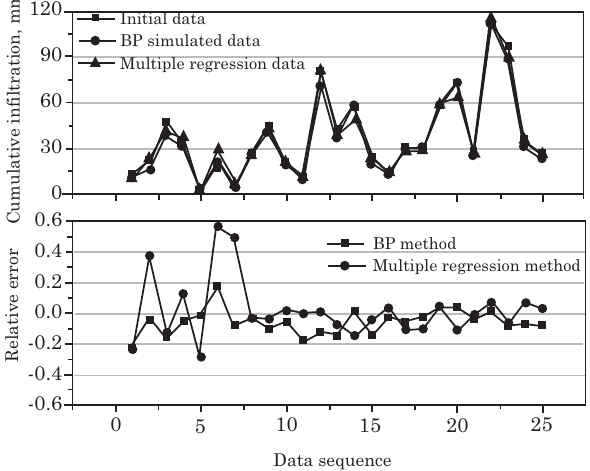
Figure 2. Comparison of Ci between a six factor BP model and multiple nonlinear regression